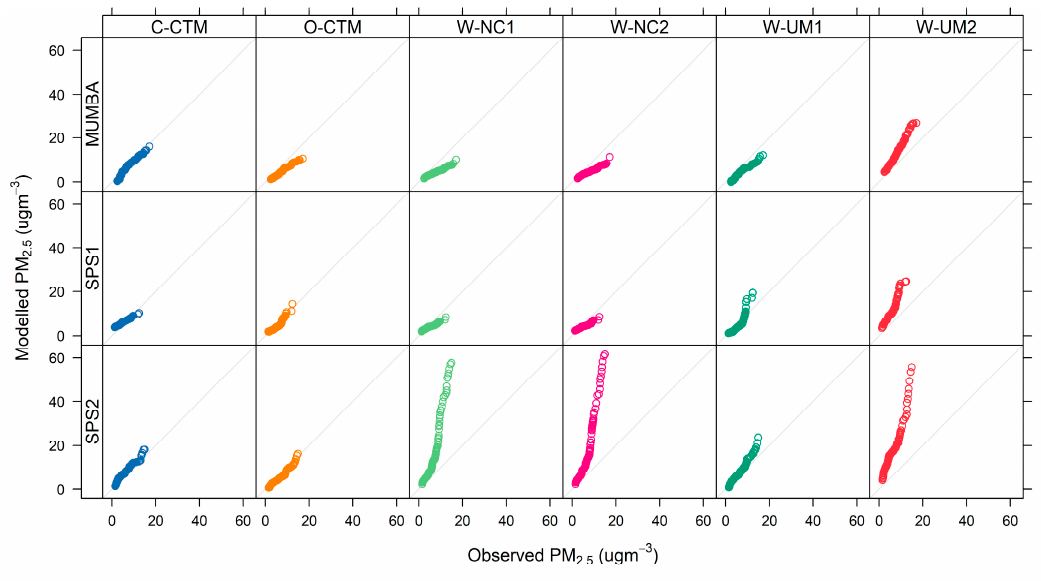
Figure 9. Quantile–quantile plot comparing modelled and observed distributions in daily PM 2.5 concentrations in µ gm − 3 for each campaign.